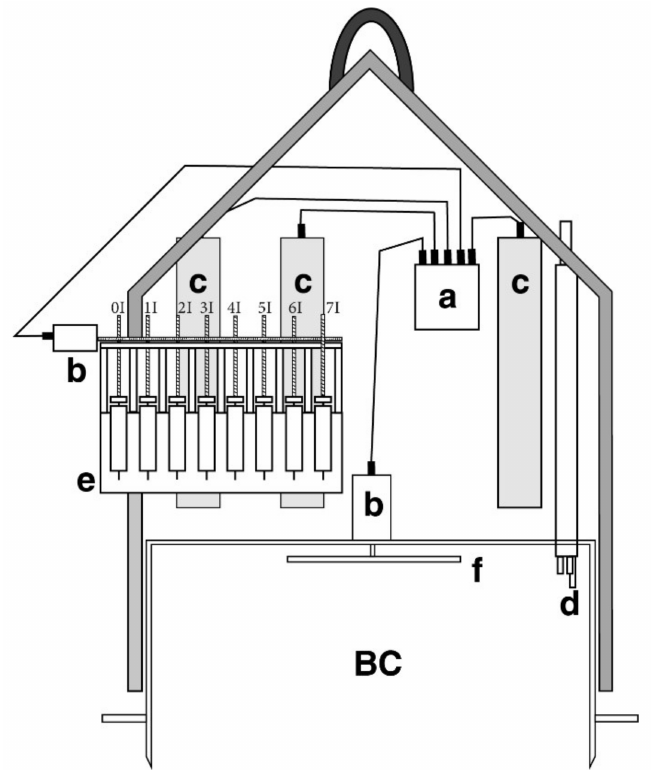
Figure 6. Schematic drawing of the Automatic Benthic chamber Ada_N. BC: measurement chamber. ( a ) electronic housing, ( b ) electric motor housings, ( c ) battery housings, ( d ) multi-parametric probe, ( e ) vampire system (sampling syringes), ( f ) rotating paddle. 0I to 7I are the vampire sampling